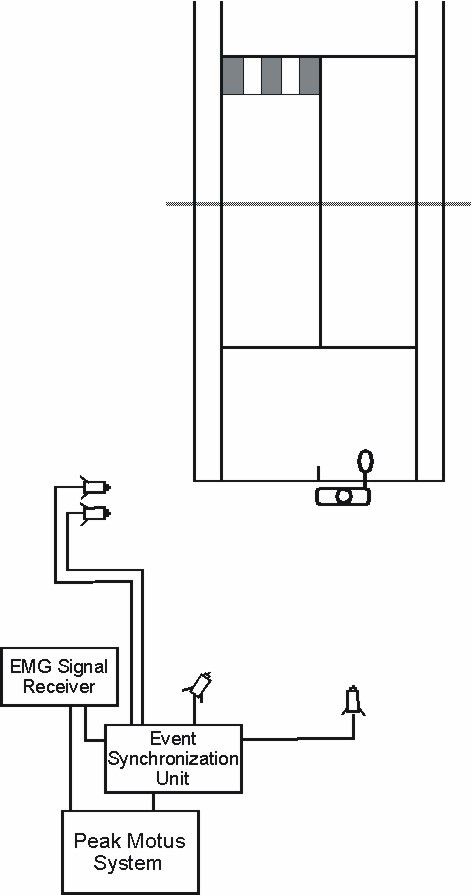
Overhead view of the experimental setup.